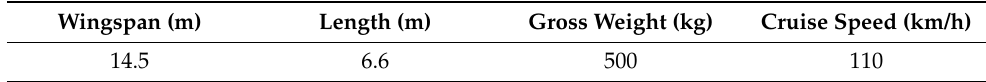
Figure 11. Two-seat all-electric aircraft RX-1E and the vortex lattice distribution [27]. Table 1. Key characteristics of the RX-1E electric aircraft.